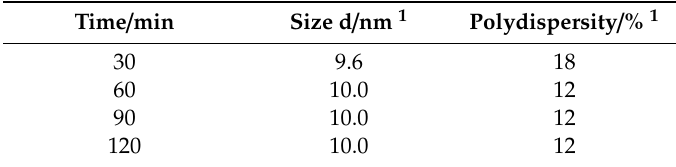
Table 2. Influence of reaction time on particle size and